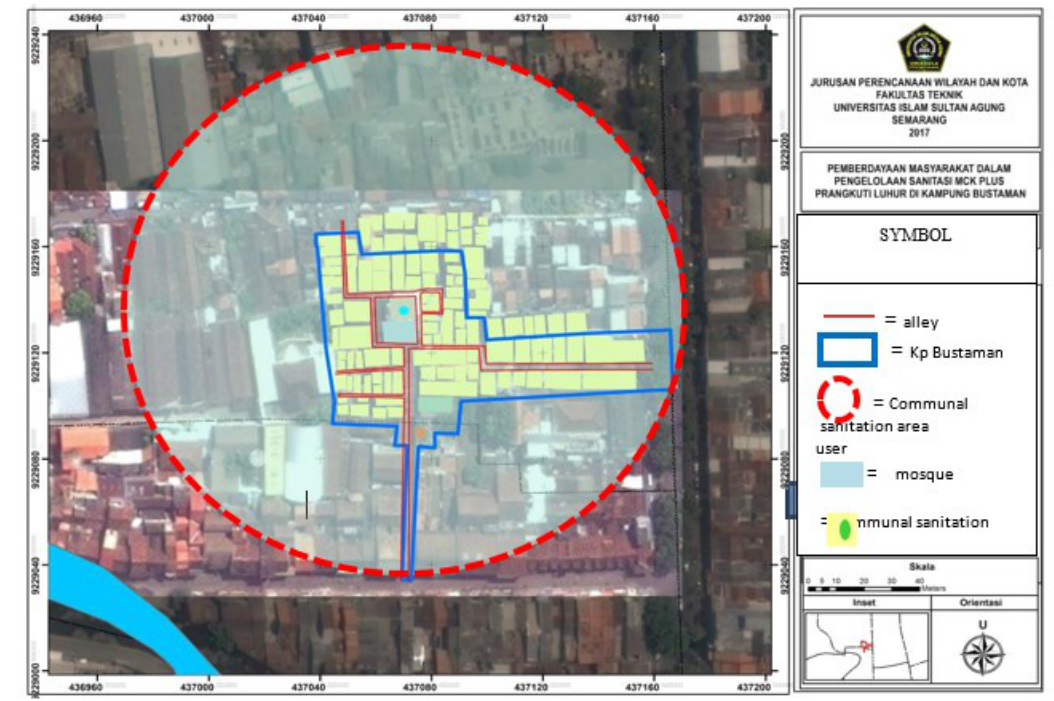
Figure 5. Coverage Area Communal Sanitation User. Source: Masterplan Semarang City with Adjust